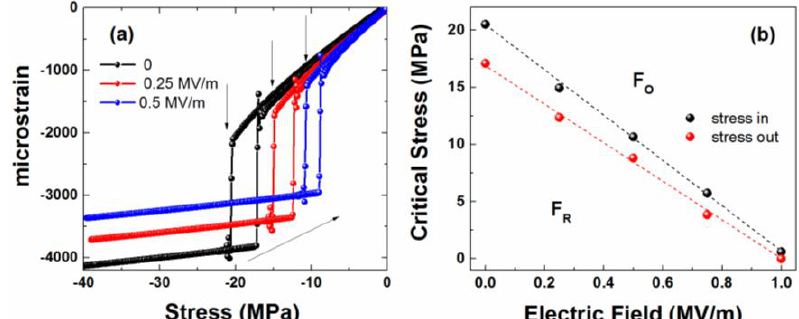
Figure 1. ( a ) Room temperature elastic response at various electric field bias and ( b ) stress-field stability region for [011] poled Pb(In 1/2 Nb 1/2 )O 3 –Pb(Mg 1/3 Nb 2/3 )O 3 –PbTiO 3 (PIN-PMN-PT) samples, where F R and F O represent stable ferroelectric rhombohedral and ferroelectric orthorhombic states, respectively.